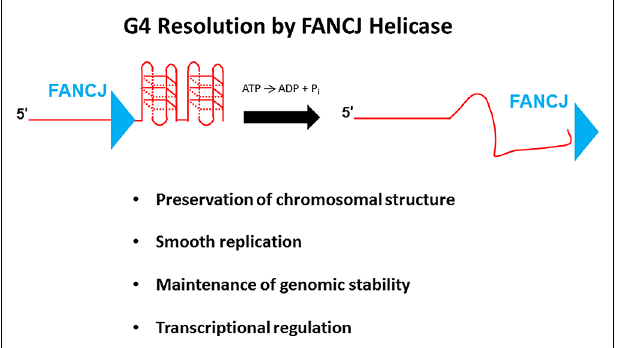
FIGURE 7 | FANCJ resolves G-quadruplex DNA to maintain genomic stability and cellular homeostasis. See text for